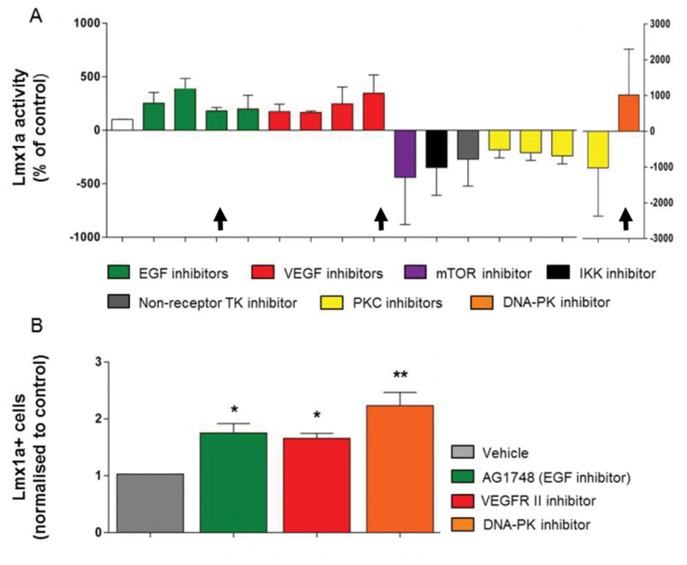
Small molecule inhibitor screens reveal multiple inhibitor classes effect Lmx1a reporter gene expression.143 kinase inhibitors were screened yielding 16 small molecule agents (SMAs) for further analysis. Panel A shows Luciferase activity on day 8 of differentiation after incubation of Lmx1a-luc mESCs with SMAs from day 4 to day 8. Panel B shows that incubation with inhibitors that promote Lmx1a activity also increases the generation of Lmx1a+ cells. Color coded bars in A represent different SMAs with known similar kinase inhibitory activity, where black arrows indicate SMAs selected for analysis in panel B See Figures S1
 and
S2
 for compound libraries used. Data expressed as mean ± SEM of at least four independent experiments. **p<0.01 and *p<0.05 one-way ANOVA with Bonferroni’s post-hoc test, n=4.